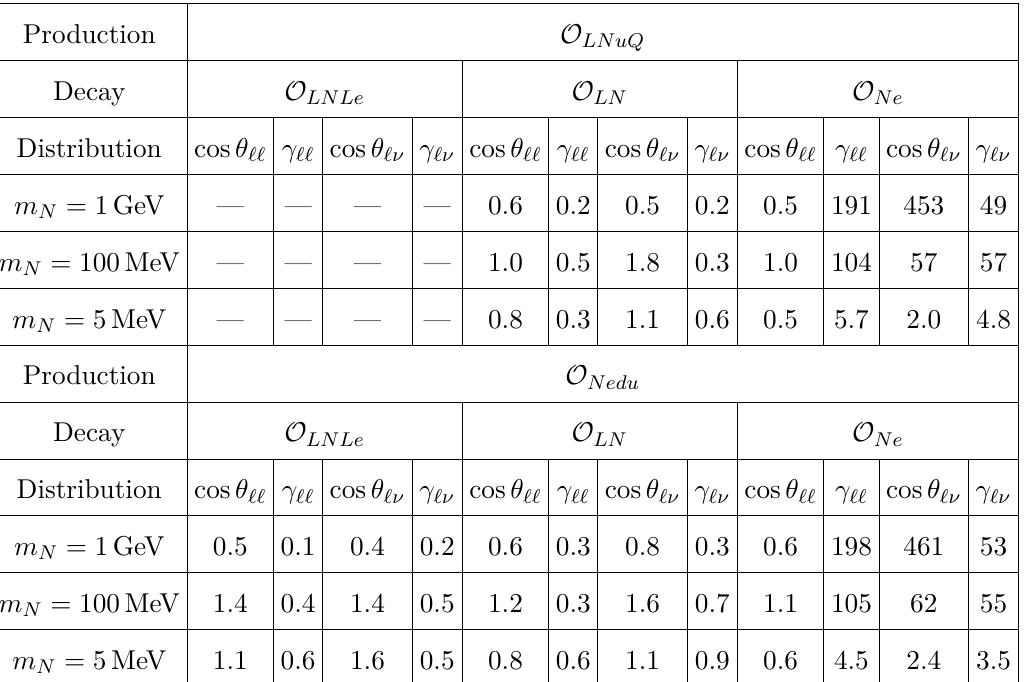
Table 11 . Determining the production and decay operators using ¯ N decay. χ 2 decay with different production and decay operators. Here, the RHN is a Majorana fermion and is produced (decays) via O LNuQ ( O LNLe